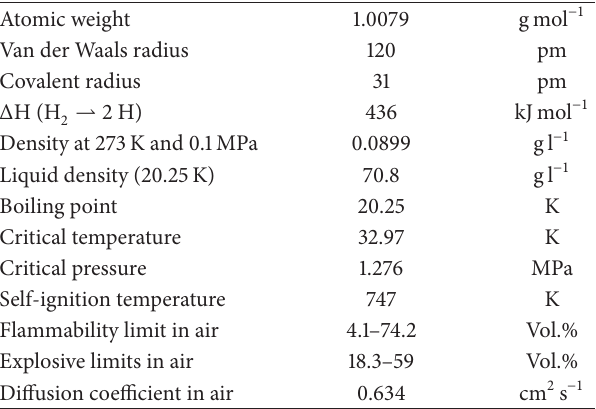
Table 1: Hydrogen